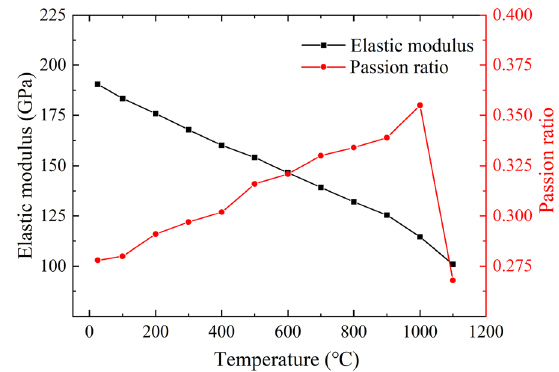
Figure 3 Elastic parameters of 304 stainless steel of different